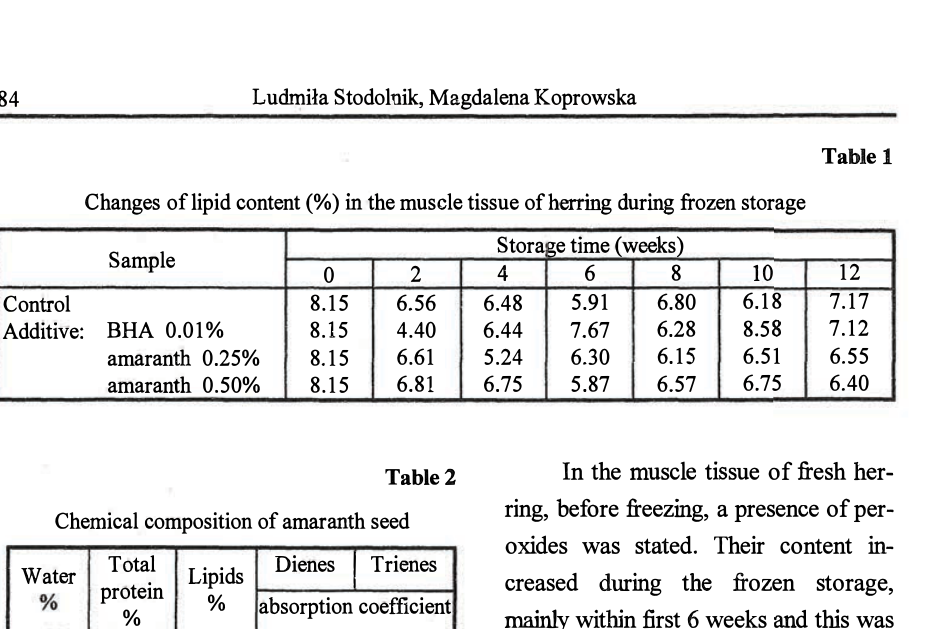
Chemical composition of amaranth seed Total Dienes j Trienes Lipids Water protein